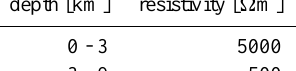
Fig. 6. Comparison of the sum of the absolute values of geomagnetically induced currents in the nodes of the Finnish high-voltage power system (11 April 2001 and 6 November 2001), as calculated with the complex image method (black line) and the local 1-D method. The absolute value of the difference is plotted as a blue line. In both cases, the total horizontal magnetic variation field is the same. The Earth’s conductivity model is given in Table 2.